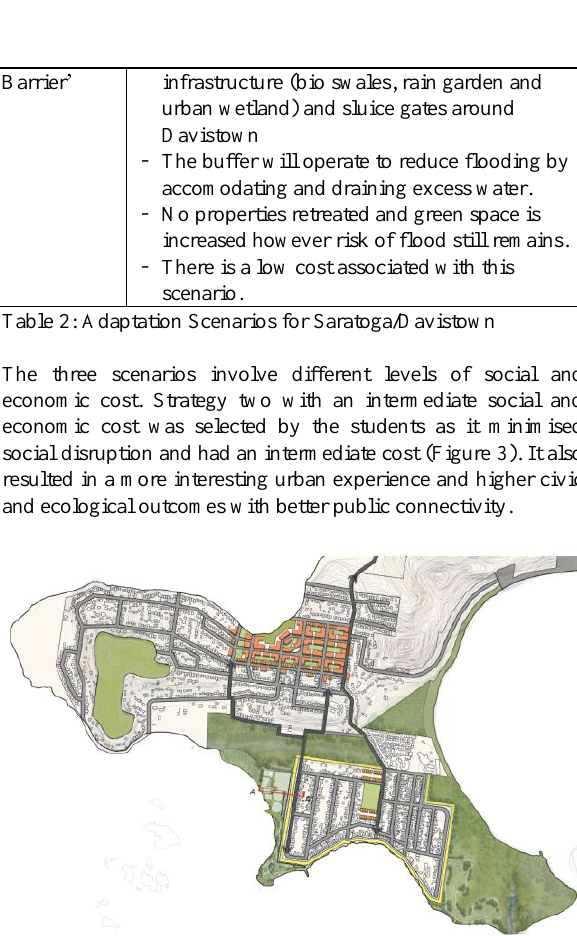
Figure 3: Scenario two coastal adaptation strategy for Saratoga / Davistown